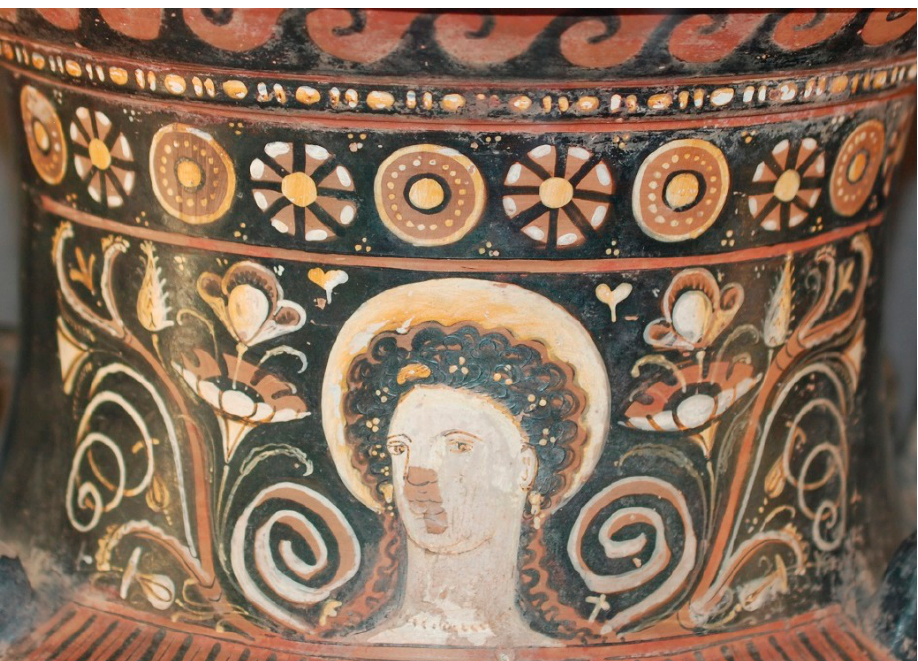
Figure 11. Bologna, Museo Civico Archeologico G 475 Apulian volute-krater, Patera Painter, ca. 340–330 B.C. Female head in three-quarter view to left surrounded by nimbus and flanked by floral tendrils (detail of neck on obverse side). Author’s photo.